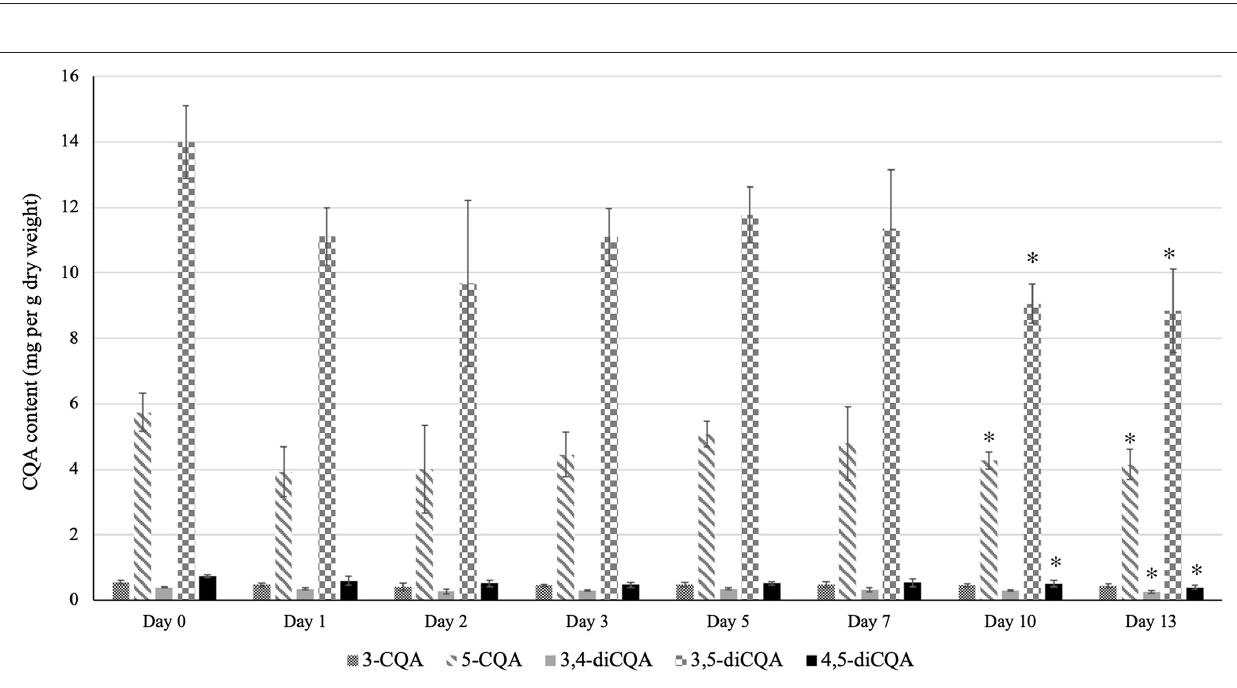
Frontiers in Nutrition |